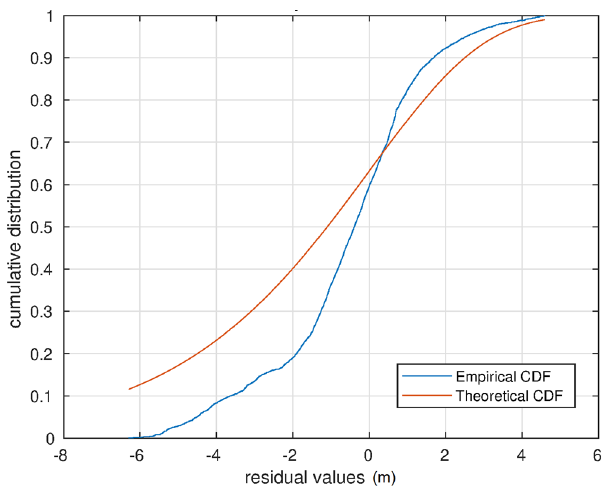
Figure 17. The empirical and theoretical cumulative distribution functions (CDFs) of the results.